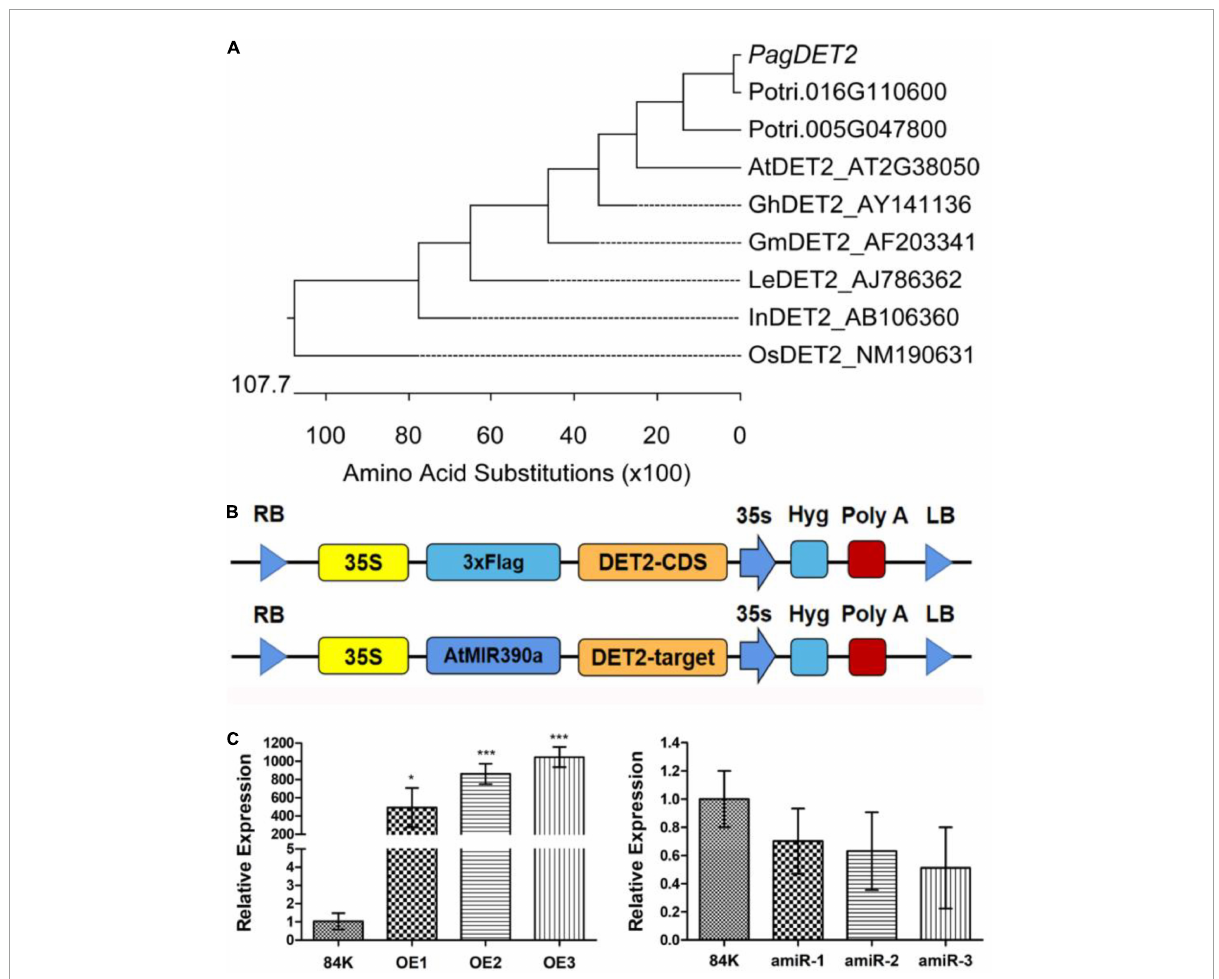
FIGURE1 Phylogenetic analysis and identification of PagDET2 transgenic lines. (A) The phylogenetic tree of PagDET2 in different plant species was plotted by MegAlign software. (B) The schematic map of constitutive overexpression vector and artificial microRNA inhibition expression vector of PagDET2 . (C) The transcription level of the PagDET2 gene in different lines. Mean ± SD. * and *** indicated significant difference at P < 0.05 and P < 0.001, respectively (Student’s t